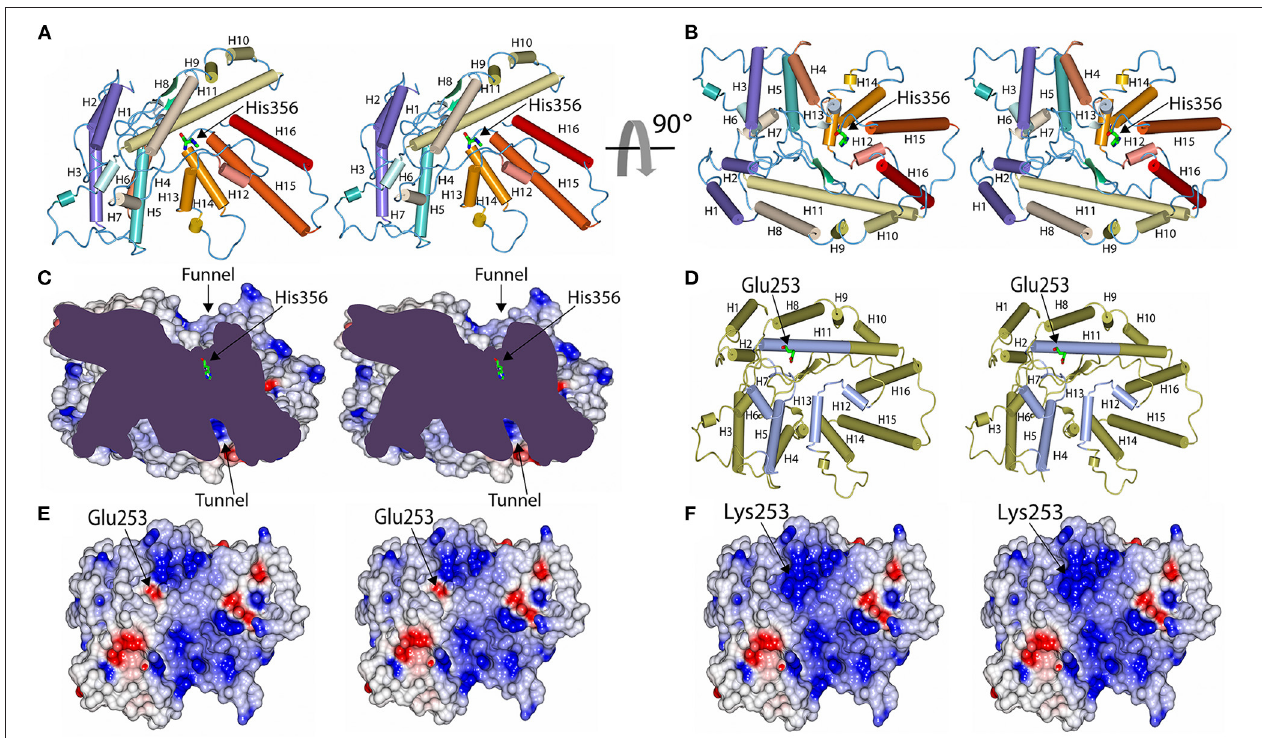
FIGURE 4 | Model structure of human MBOAT7 protein and structural comparison between wild-type and variant MBOAT7. The human MBOAT7 model structures are drawn in two orientations with tube diagrams (A,B) and a cut-away surface charge distribution (C) in stereo views. The locations of the funnel which were oriented to the extracellular surface and the tunnel, which was directed to the cytosolic space, are indicated. The active site histidine residue (His356) was located at the bottom of the funnel. Tube diagram and surface charge distribution display in stereo views of the wild-type (D,E) and mutant MBOAT7 models (F) oriented to look down the funnel. In this orientation, the position of Glu253 in the wild-type (E) and Lys253 in the mutant (F) are shown in the middle of the funnel. Accordingly, the surface charge distribution of the funnel was altered by a mutation from Glu to